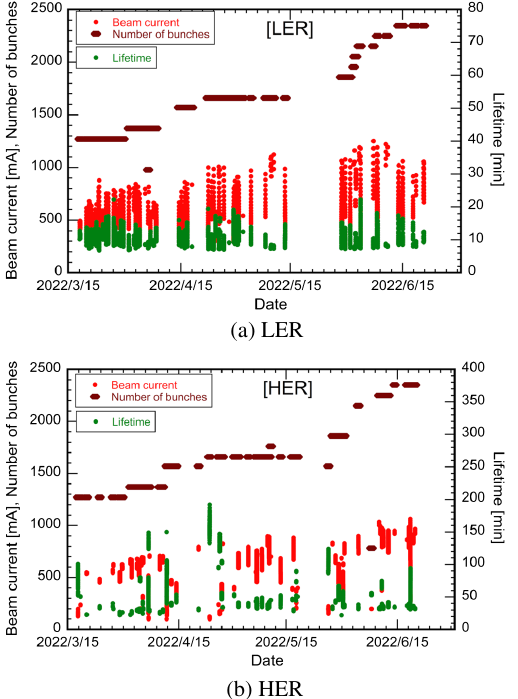
FIG. 12. Trends of I , τ , and N b used for the MRA to estimate the influence of the pressure and Touschek effect on τ from the 15th of May to the 21st of June 2022 for (a) LER and (b) HER (single-beam mode).